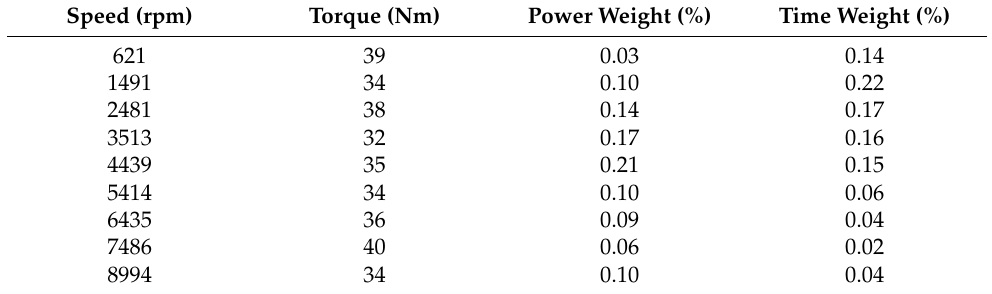
Table 2. 9 characteristic points.